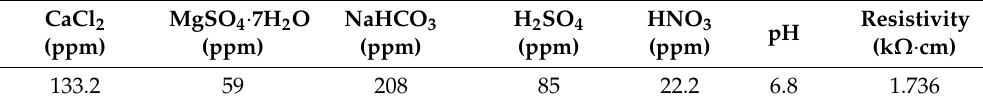
Table 1. Chemical composition of synthetic groundwater.